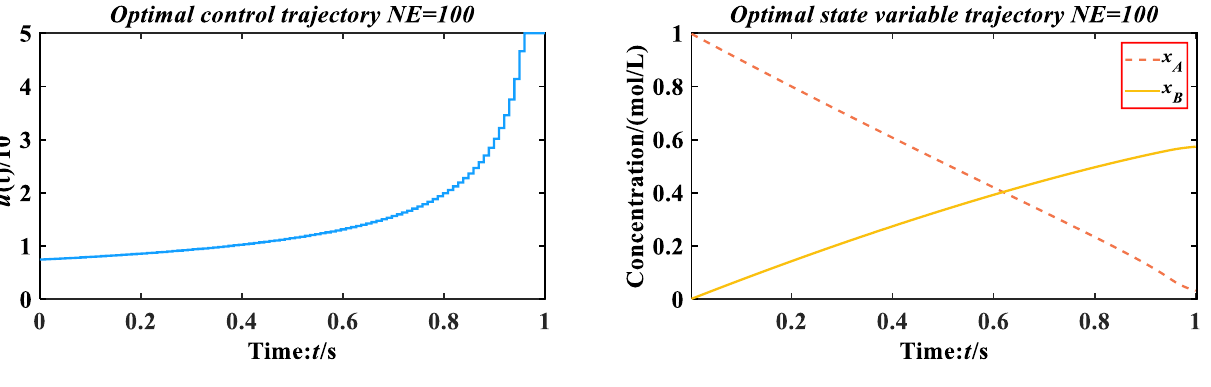
Figure 25. CM-HSSA for Problem 3.